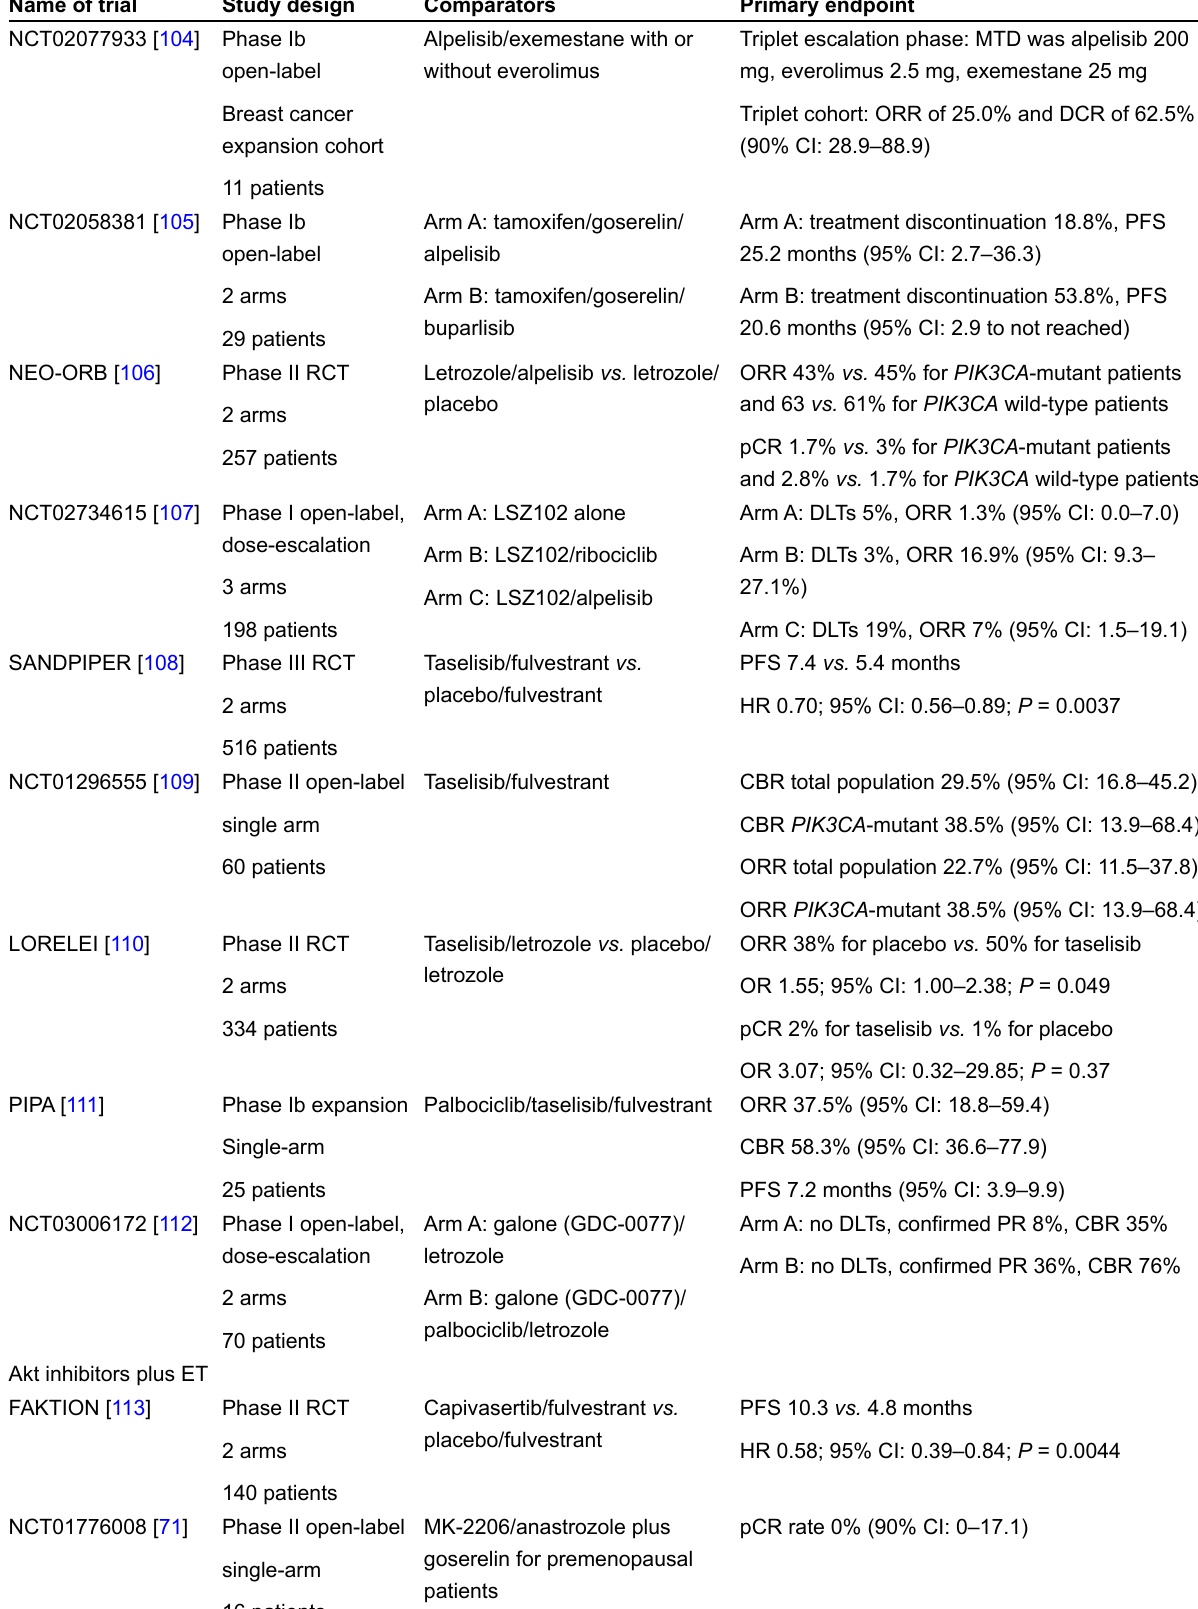
Table 1. Published clinical trials combining ET and inhibitors of the PI3K/Akt/mTOR pathway ( continued ) Name of